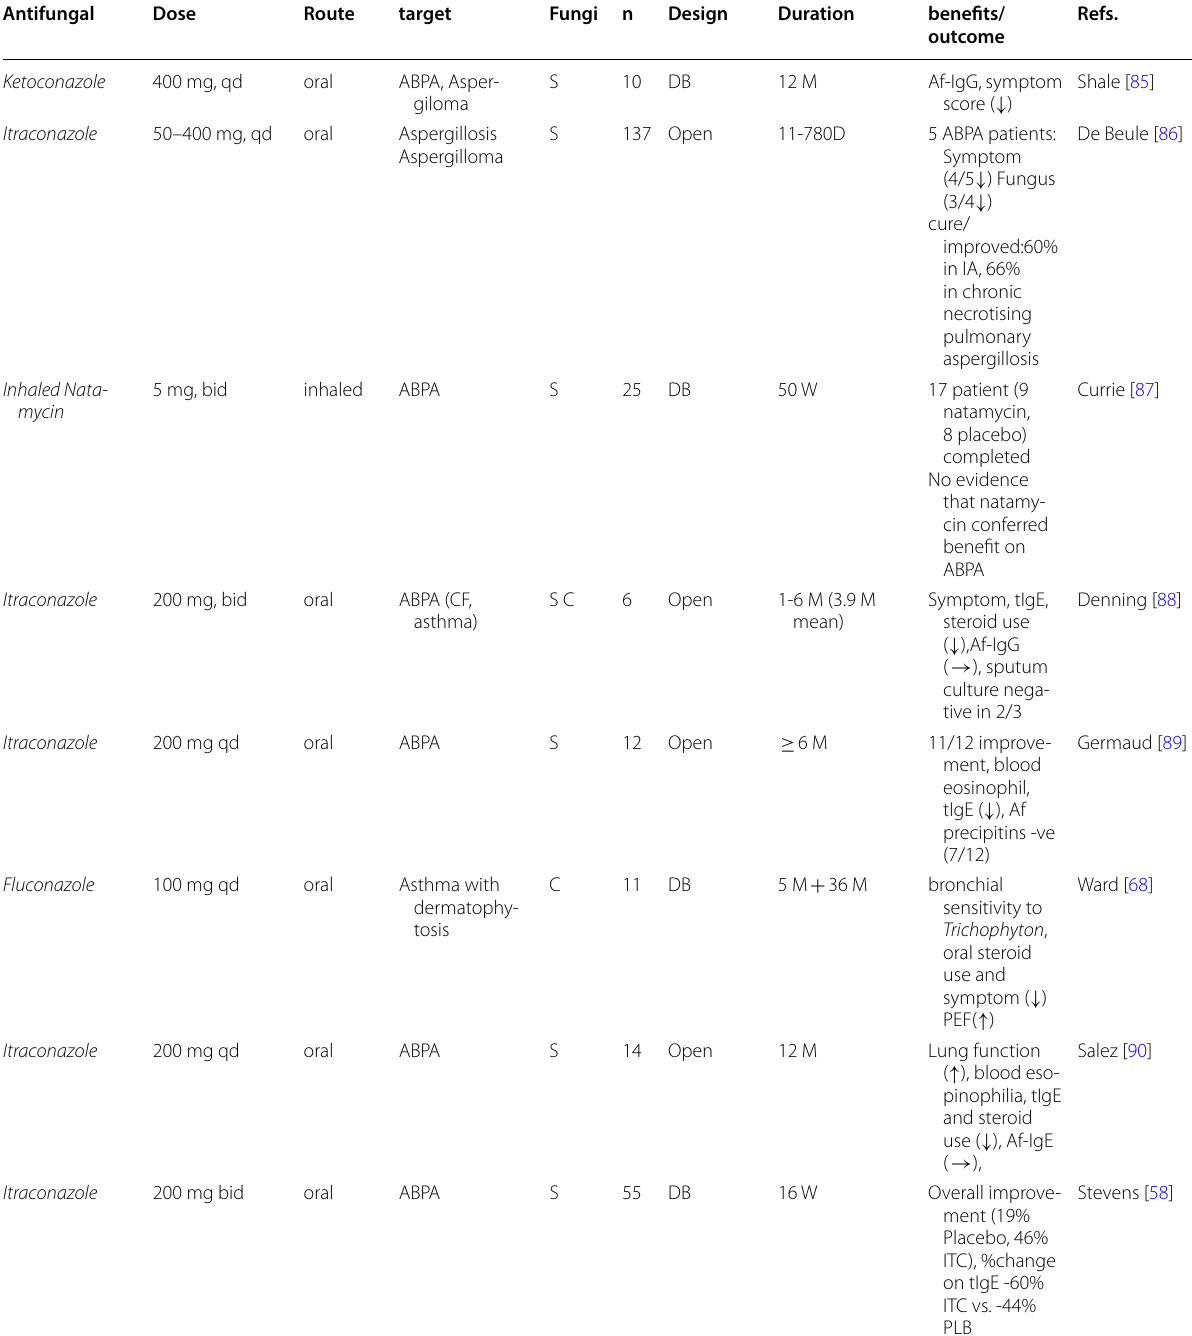
Table 2 Overview of antifungal clinical studies (Chronological